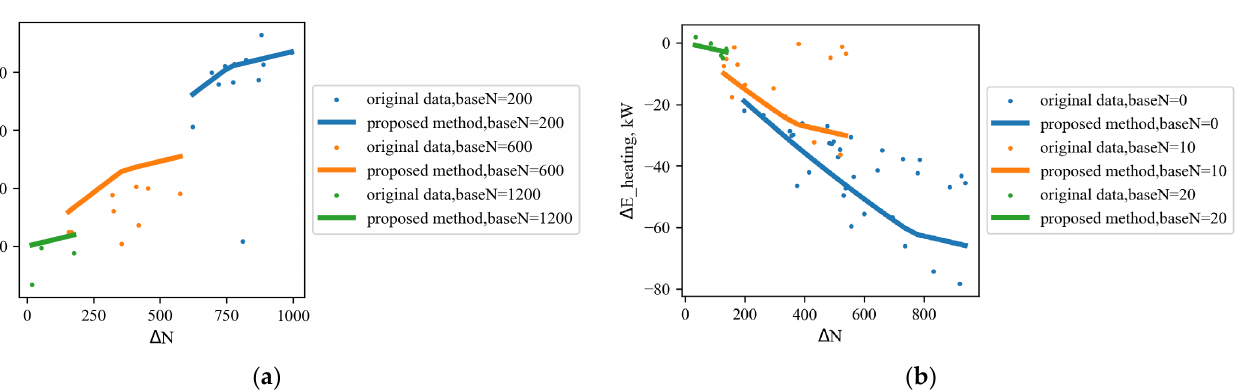
Figure 14. Comparison of ∆E hvac calculated by the proposed method and actual data in ( a ) cooling, condition (Tout = 32 °C) and ( b ) heating condition (Tout = 11 °C).